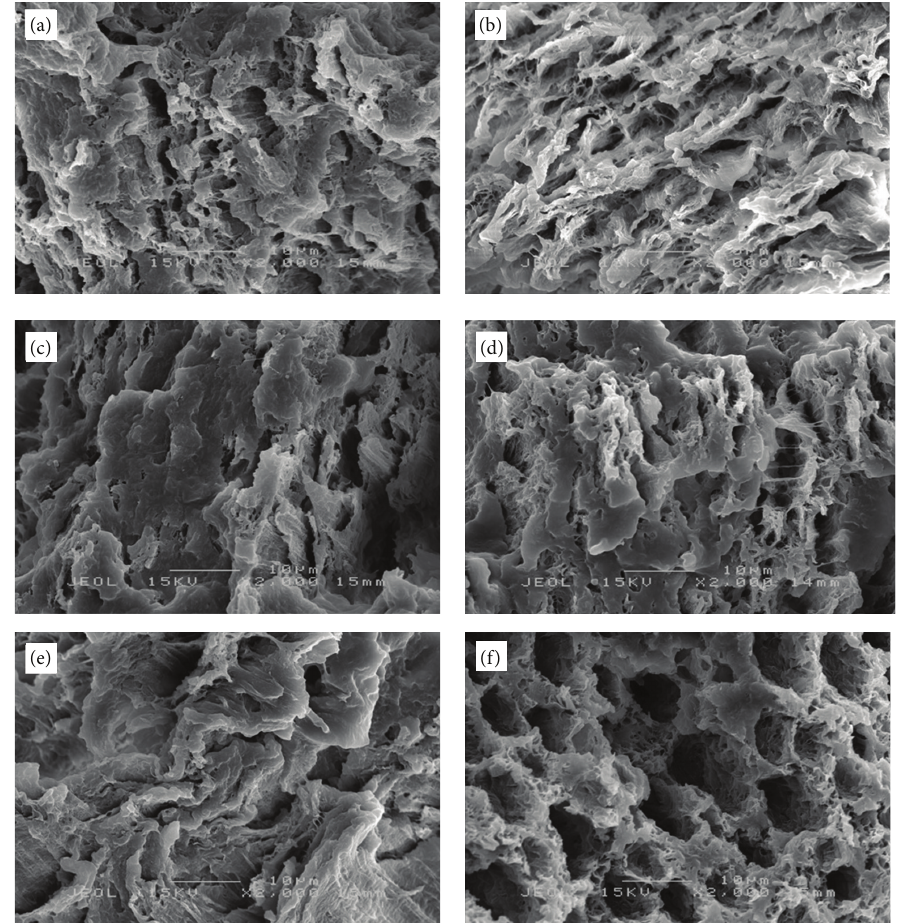
Figure 9: Scanning electron micrographs of (a) 80PHB/20PCL blend and PHB/PCL/stearate Mg-Al LDH nanocomposites with (b) 0.25, (c) 0.5, (d) 1, (e) 1.5, and (f) 2wt% stearate Mg-Al LDH content at 2000x